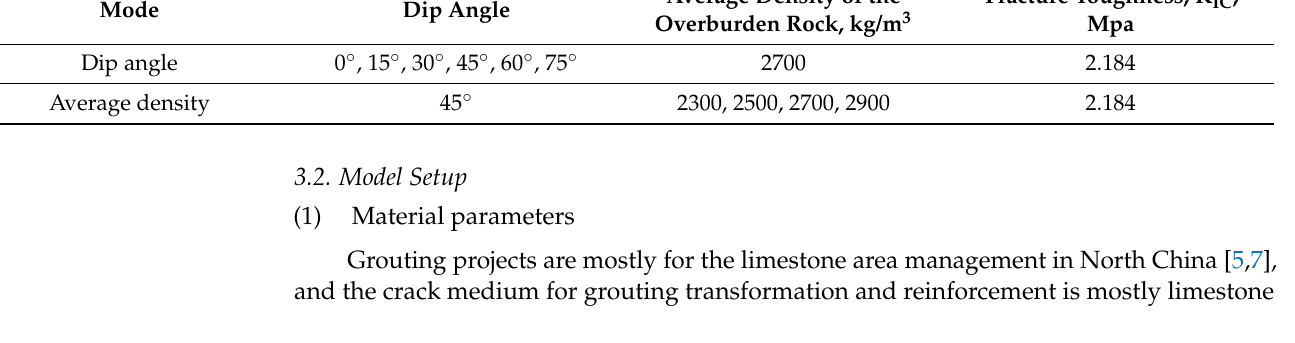
Table 2. Numerical simulation parameters. Parameter Name